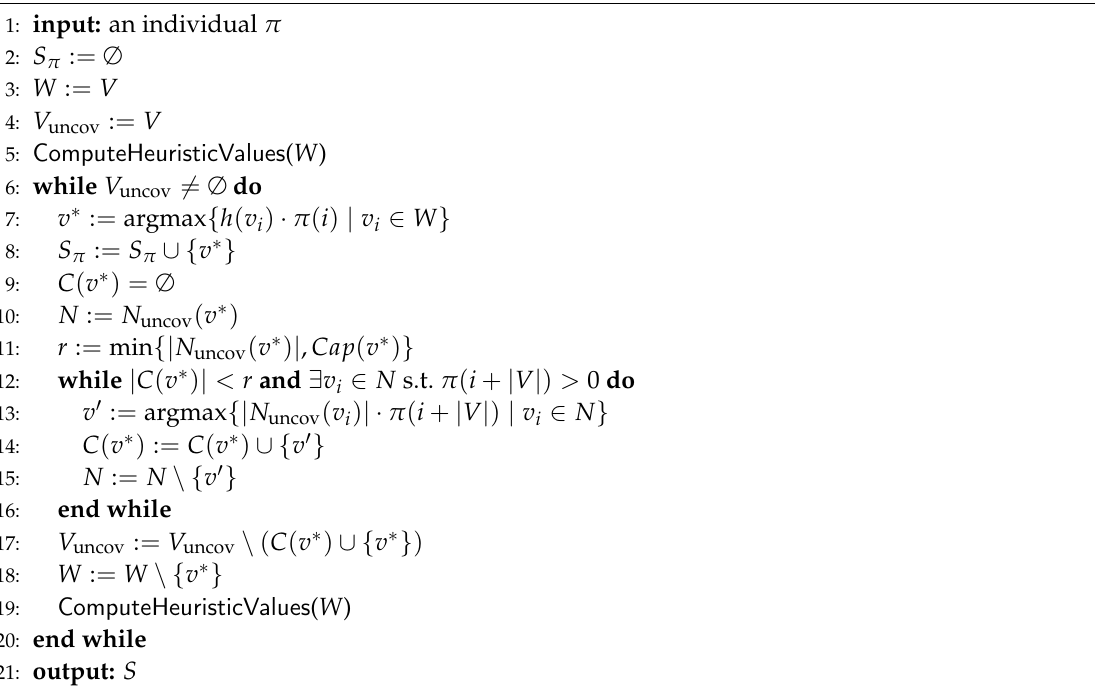
Algorithm 4 Evaluation of an individual in B